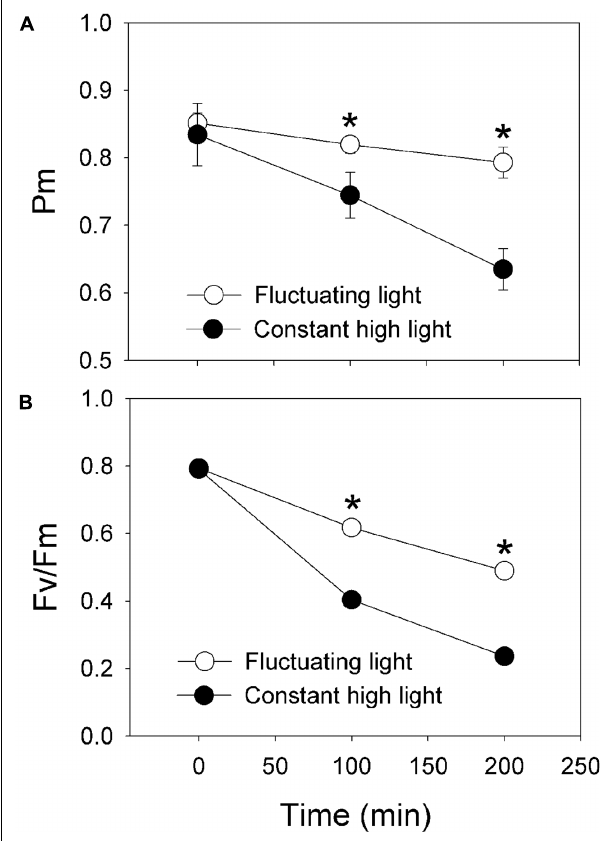
FIGURE 5 | Effects of intense fluctuating light on PSI (A) and PSII (B) activities. The maximum photo-oxidizable P700 ( P m ) and the maximum quantum yield of PSII ( F v / F m ) were measured before and after treatment with moderate fluctuating light as shown in Figures 3 and 4 . Values were measured following 30 min dark adaptation. The means ± SE were calculated from at least four